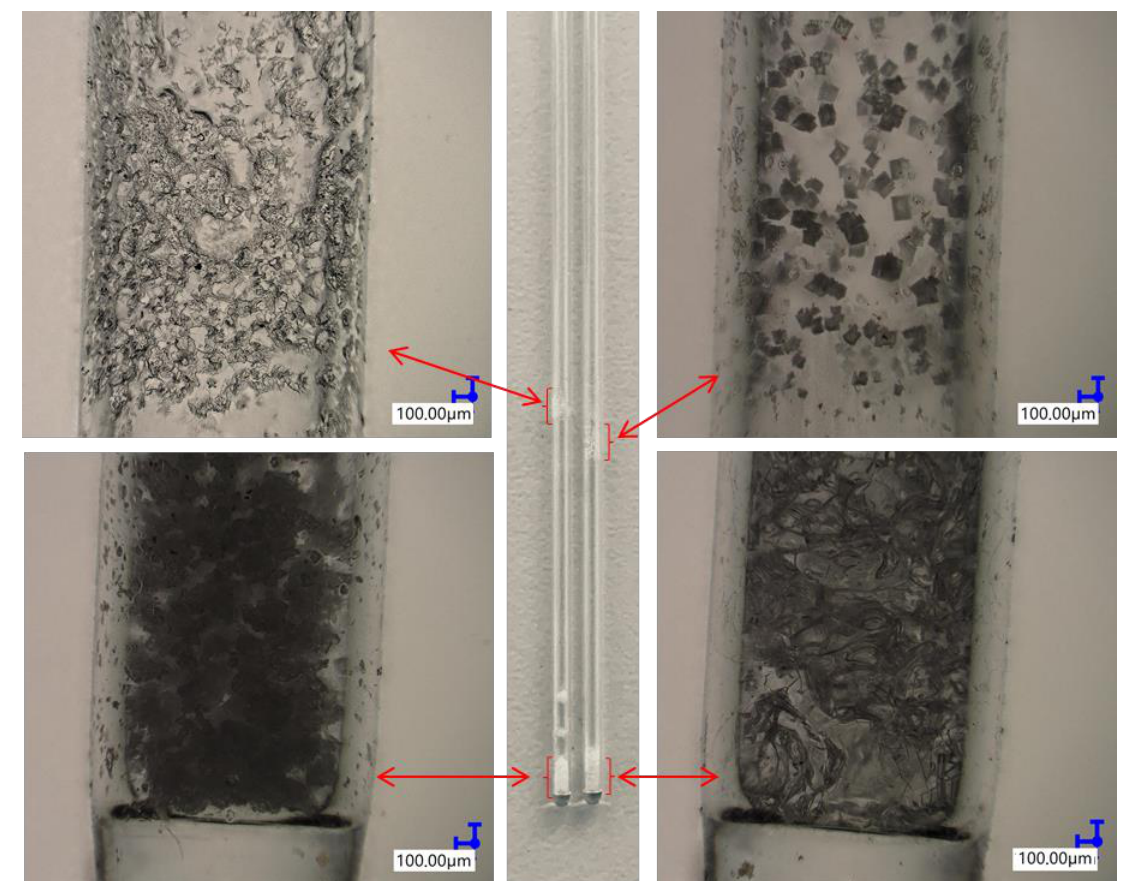
Figure 7. Pictures taken with an optical microscope of capillaries for which both the sublimation process and the thermal decomposition of iBu 7 SS-H and SS-8H derivatives were observed. decomposition of iBu 7 SS-H and SS-8H derivatives were